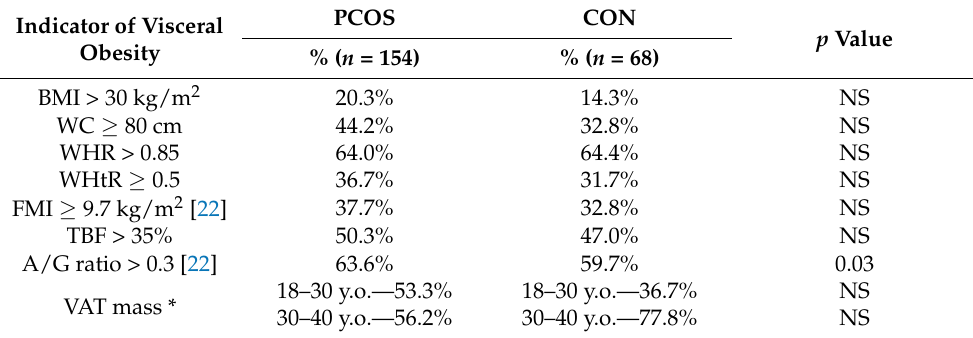
Table 3. Presence of simple obesity and visceral obesity in PCOS and CON women based on classical cut-offs of selected visceral adiposity indicators.